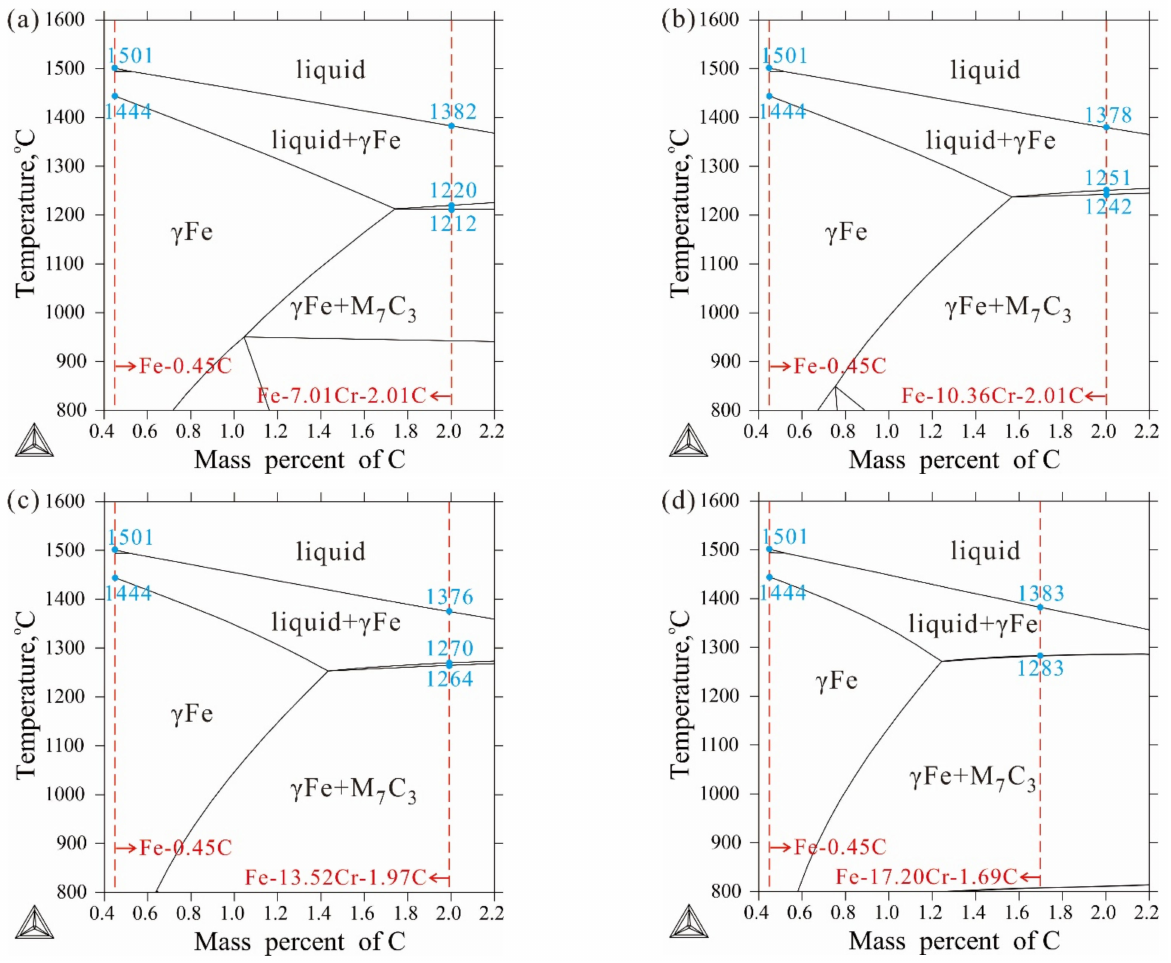
Figure 6. Calculated vertical sections along the compositions from ZG45 to CILs with the variations in C contents. ( a ) CIL-1; ( b ) CIL-2; ( c ) CIL-3; ( d ) CIL-4.